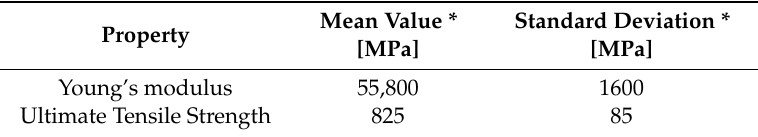
Table 1. Mechanical